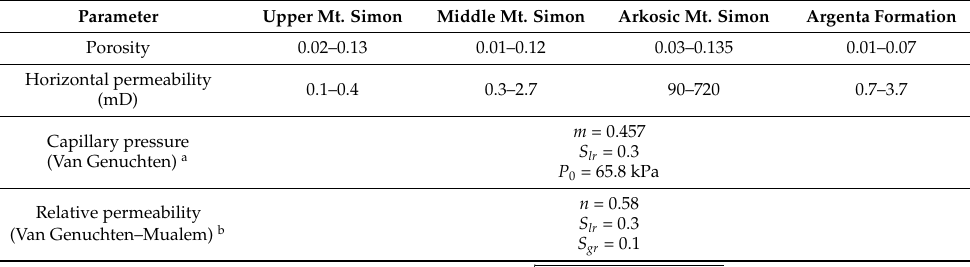
Table 1. Hydrogeological properties of the model.